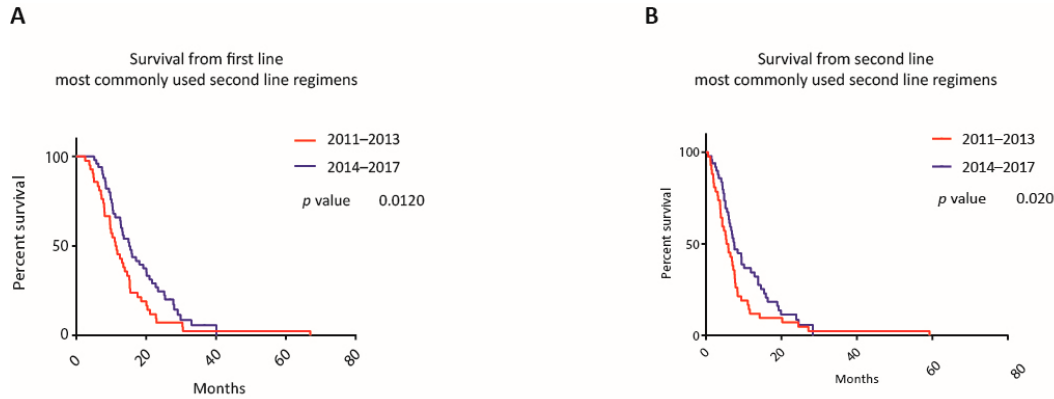
Figure 6. Survival according to first line and second line treatment for most popular regimens. Kaplan-Meier curves of patients who were treated with one of the most popular second line treatment regimes, calculated from the initiation of the first ( A ) and second ( B ) treatment line according to the year when the first systemic treatment was administered. The most popular treatment lines were gemcitabine / nab-paclitaxel, gemcitabine / (capecitabine) / erlotinib, as well as fluoropyrimidines / oxaliplatinforthecohort2011–2013andfluoropyrimidines / nanoliposomalirinotecan, as well as fluoropyrimidines / oxaliplatin for the cohort